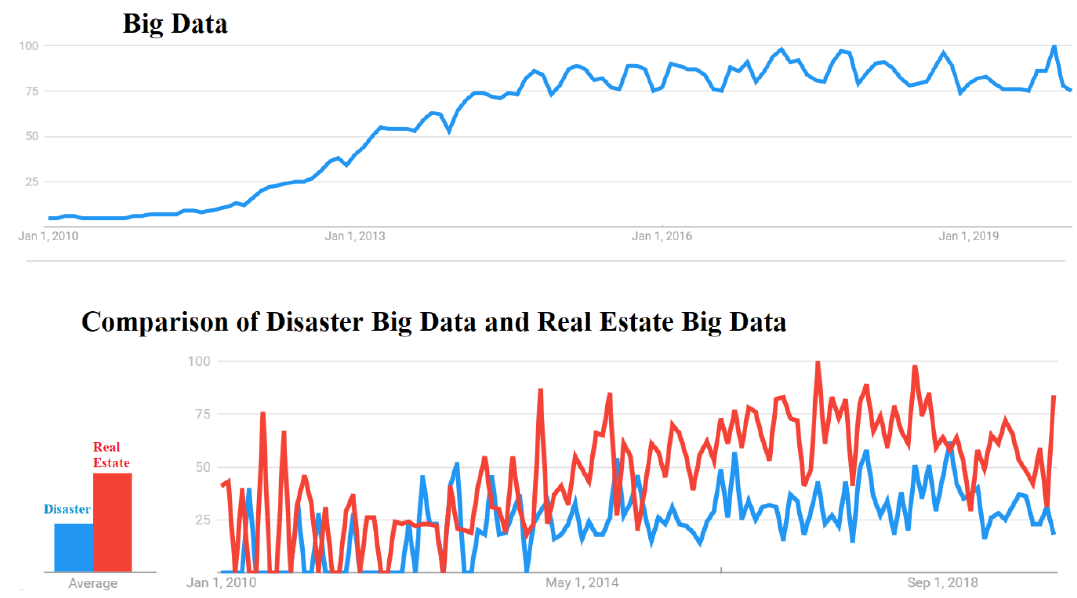
Figure 6. Worldwide big data, disaster big data, and real estate big data search trends in last decade.